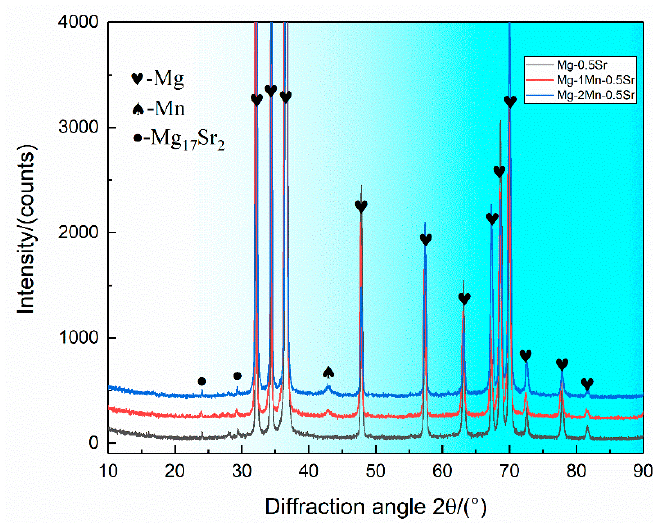
Figure 3. XRD patterns of as-extruded Mg-0.5Sr-xMn alloys, x = 0, 1, and 2 (wt.%).